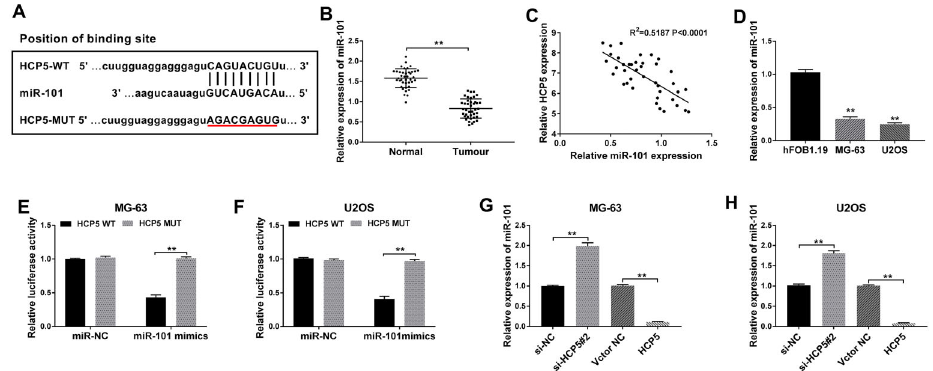
Figure 3. HCP5 directly targeted miR-101. A , The online software miRcode predicted the putative binding sites between HCP5 and miR- 101. B , The expression of miR-101 was exhibited in osteosarcoma (OS) tissues and adjacent normal tissues. C , Correlation between the expression of HCP5 and miR-101 in OS tissues. D , The expression of miR-101 was measured in OS cell lines MG-63 and U2OS and normal cells hFOB 1.19. E and F , Luciferase reporter assay was performed to con fi rm the interaction between HCP5 and miR-101 in MG-63 and U2OS cells. G and H , Relative expression of miR-101 was examined in MG-63 and U2OS cells transfected with si-NC (negative control), si-HCP5#2, vector NC, or HCP5. Data are reported as means ± SD. ** P o 0.01 (Student ’ s t -test and